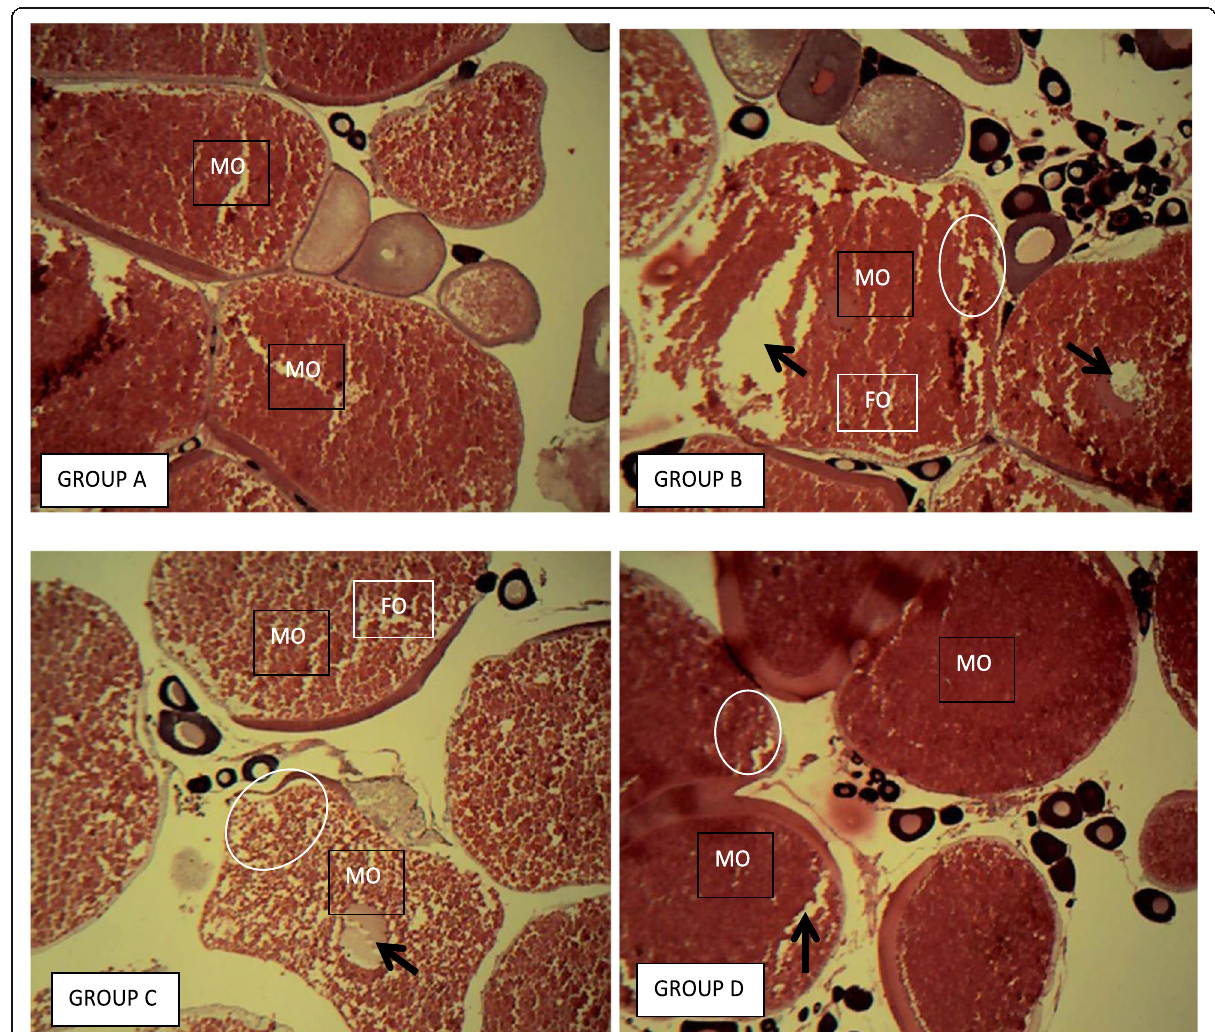
Fig. 7 Histopathology of the ovary of C. gariepinus exposed to different concentration of lambda-cyhalothrin on day 28. Group A (control), B (2.5 × 10 − 4 μ g/L), C (5.0 × 10 − 4 μ g/L), and D (8.25 × 10 − 4 μ g/L) (MO, mature oocyte; FO, flabby oocyte; white circle, degenerative ovarian changes; black arrow, vacuolation; H&E; Mag. ×